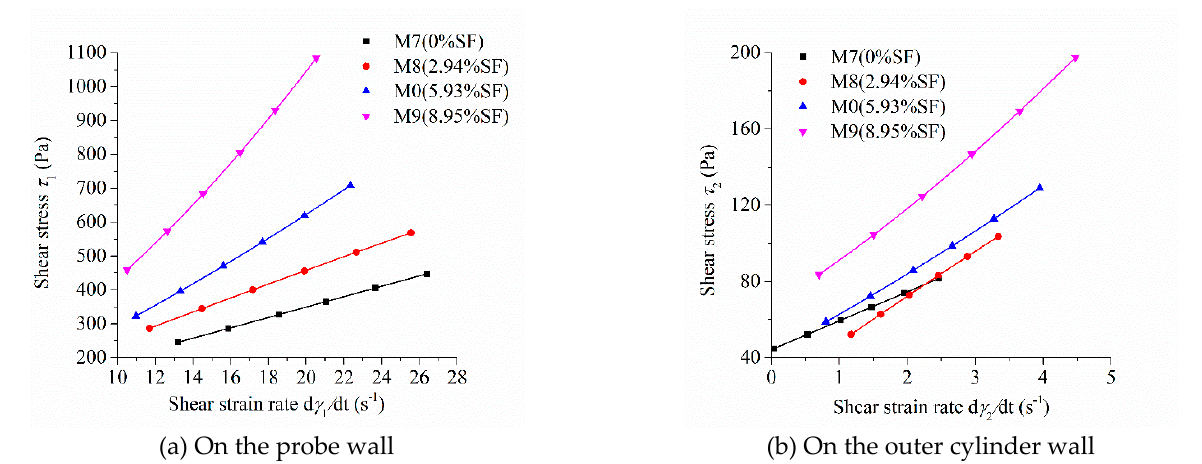
Figure 7. Relationship between shear stress and shear strain rate of mortars with different silica fume (SF) contents.